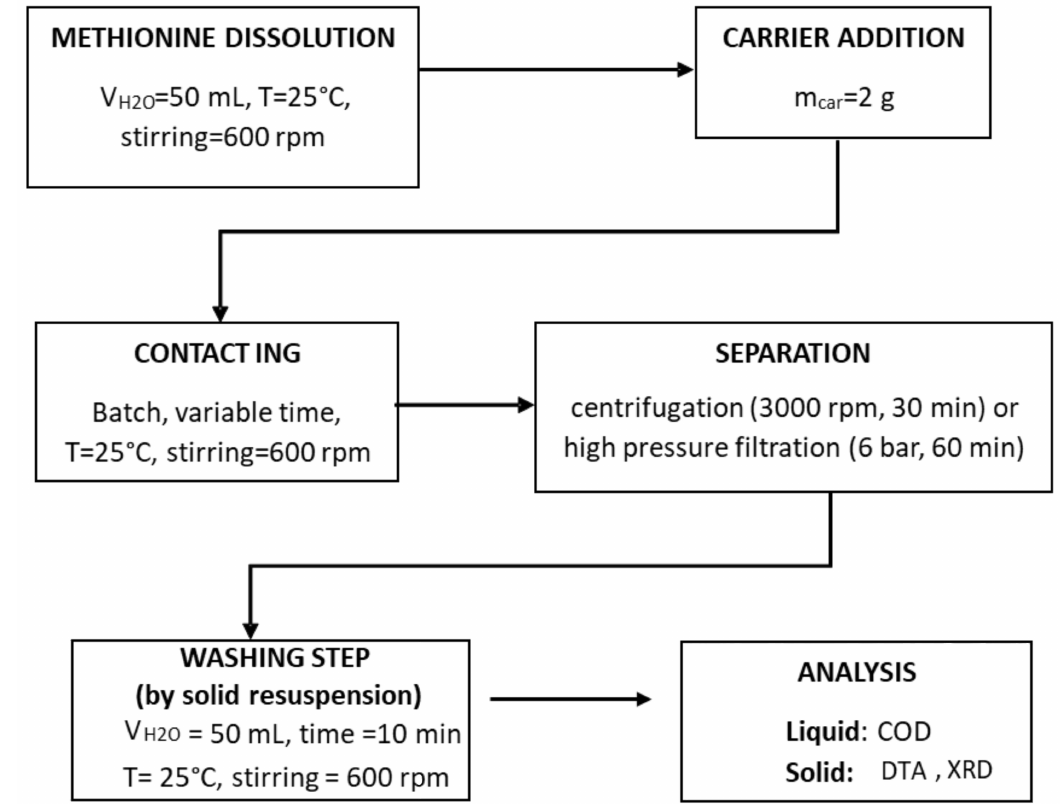
Figure 1. Flowchart of the single intercalation